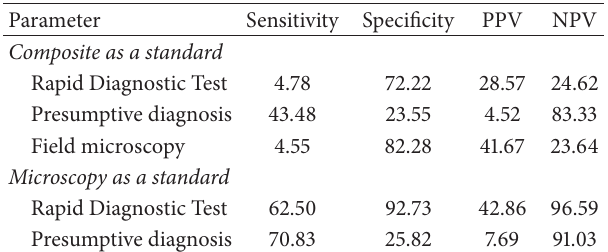
Table 1: Performance of rapid, presumptive, and microscopic diag- nostic test using the composite and microscopy as gold standards.